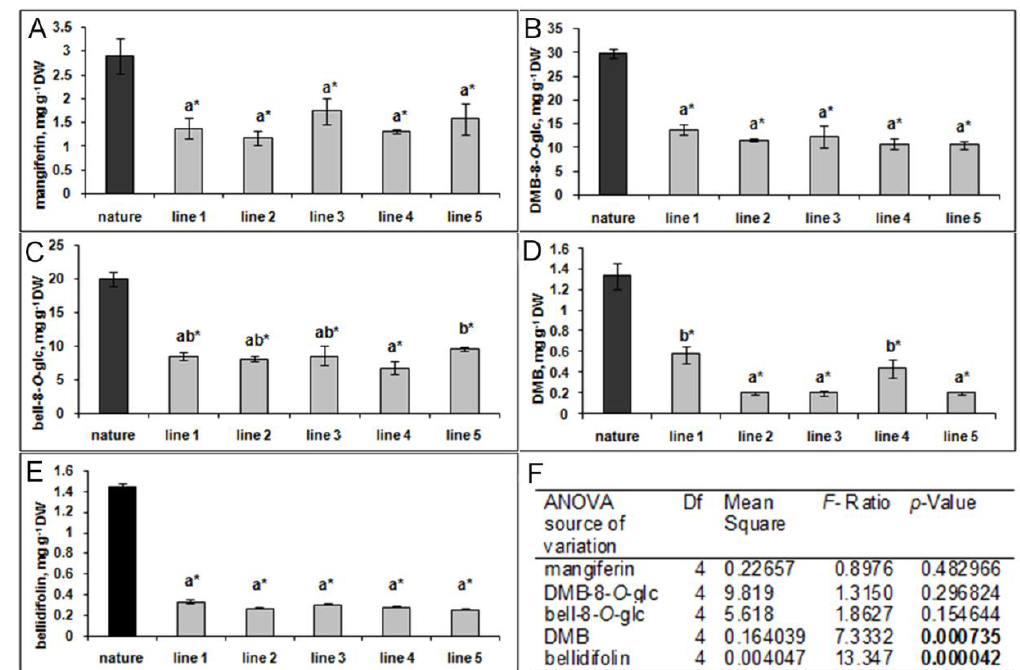
Figure 5. The content of xanthones mangiferin ( A ), demethylbellidifolin-8- O -glucoside (DMB-8- O -glc) ( B ), bellidifolin-8- O -glucoside (bell-8- O -glc) ( C ), demethylbellidifolin (DMB) ( D ) bellidifolin ( E ) in five shoot lines of G. lutescens cultured on BM + 0.2 BA mg L −1 for 35 days. Wild G. lutescens herb grown in nature was used as a control. Values are the means ± SE of four to six biological replicates (n = 4–6). Data of xanthones content in shoot lines were analyzed by one-way ANOVA ( F ). The values followed by different letters were significantly different according to Fisher’s LSD test at p ≤ 0.05; asterisk (*) indicate a significant difference of values between in vitro shoot lines and wild plants samples according to Student’s t -test at p ≤ 0.05.